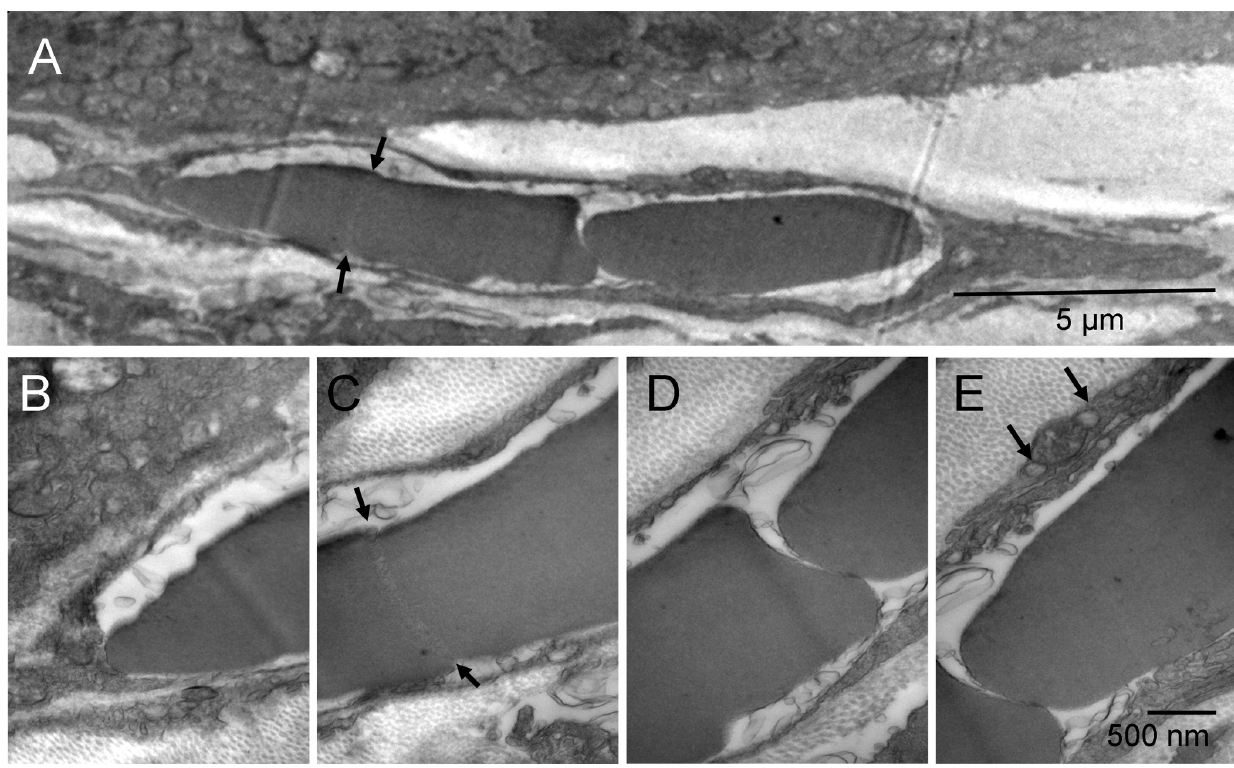
Figure 3. Erythrogenic autophagy in elongated cell between tumor nodules; resemblance to the vasculogenic mimicry. Consecutive splitting of an erythroschizont (red-splitting-body) into erythromers (erythrosomes); one fragment completely separated and the rest in the process of splitting, all surrounded by leftover cytoplasm of the cell producing them [ A ]. Four enlarged regions of that cell [ B – E ]. A distinct region of the erythroschizont indicated location of the next, already initiated, split (arrows) [ A & C ]. Vesicles on both sides of the mitochondrion contained collagen fibers (arrows) [ E